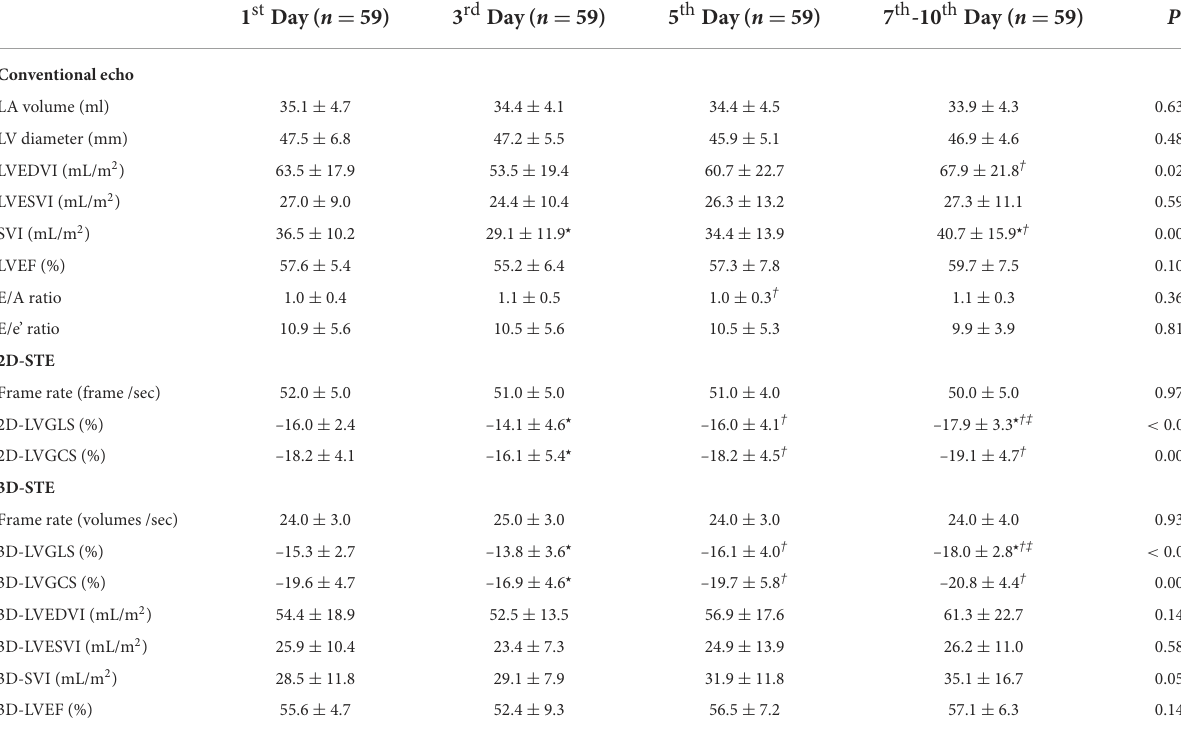
TABLE 3 Echocardiographic Parameters by 2D and 3D Measurements over time in patients.